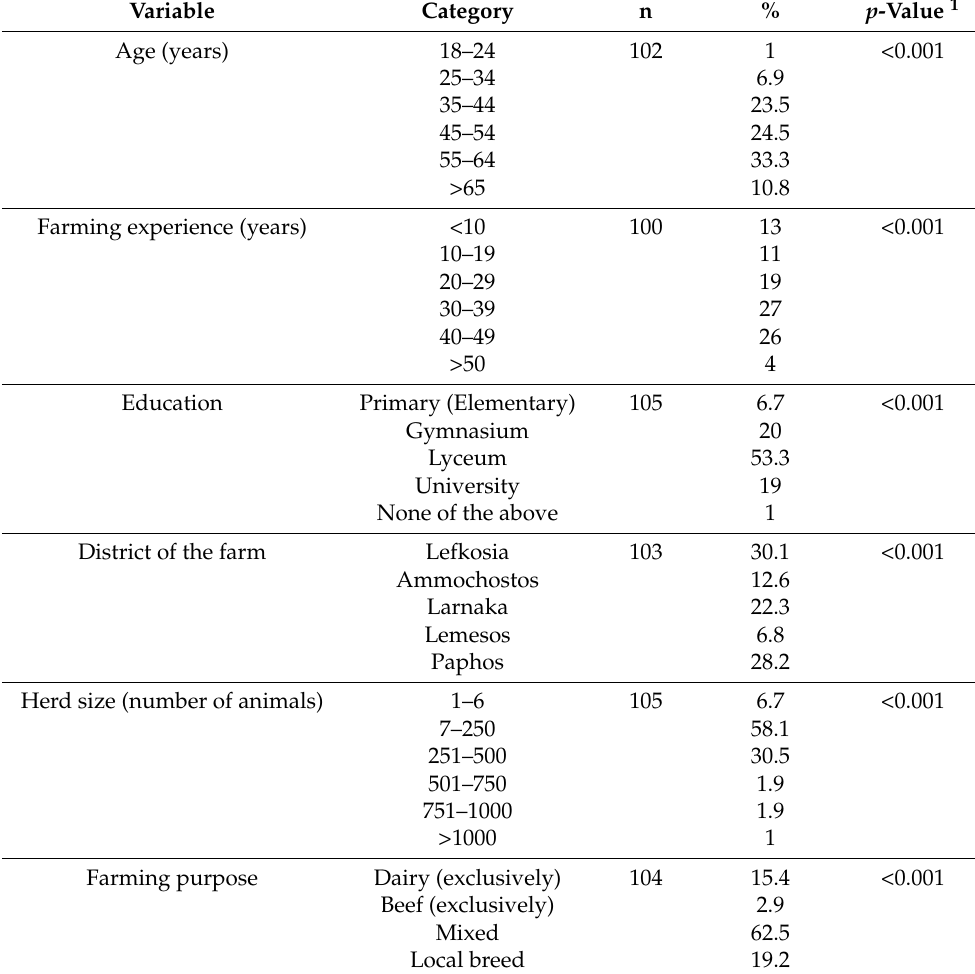
Table 1. General characteristics of